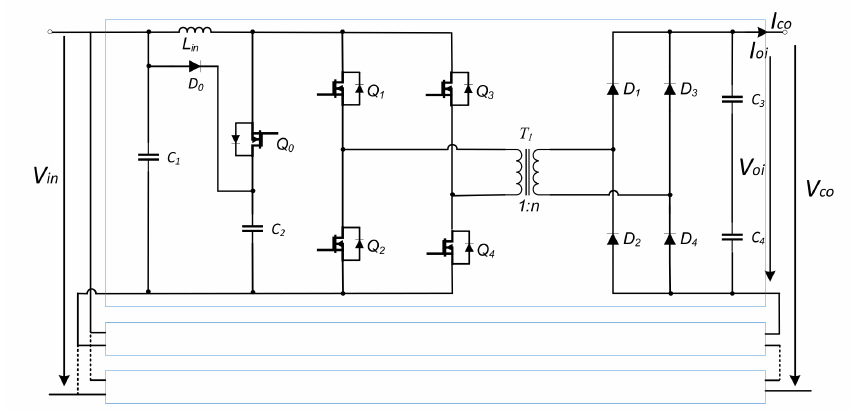
Figure 2. Topology of series-connected PV MVDC